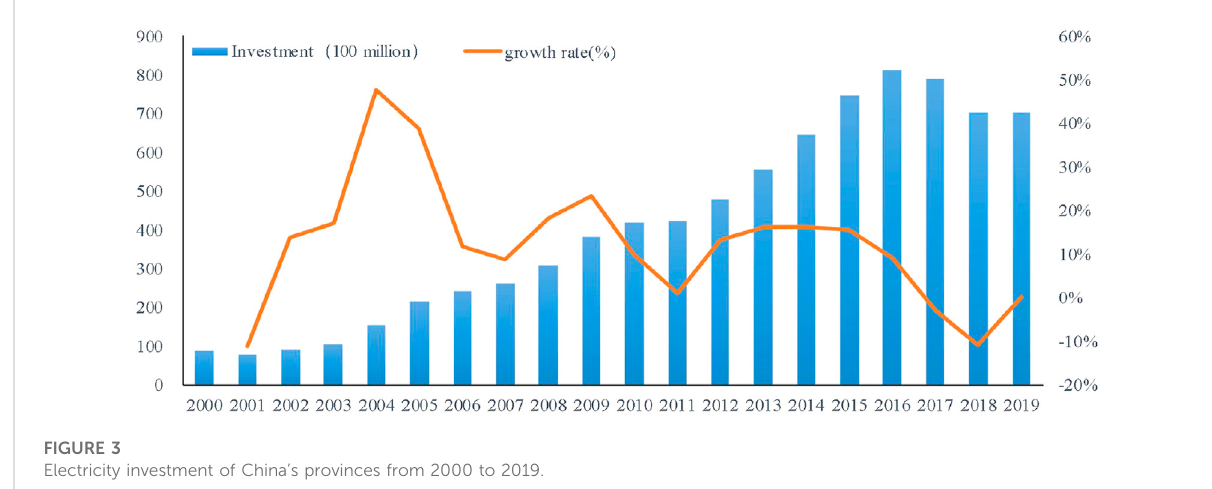
FIGURE 3 Electricity investment of China ’ s provinces from 2000 to 2019.